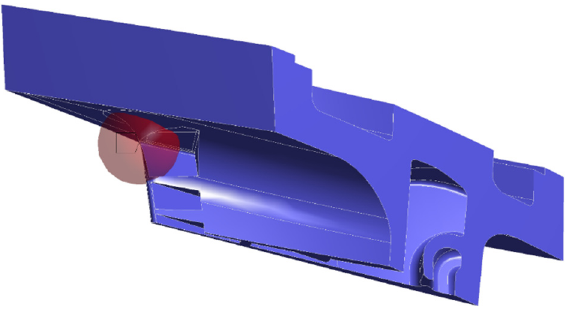
Figure 7. Mesh around the PETE with a sphere of influence of 8 mm radius and 0.5 mm element size.